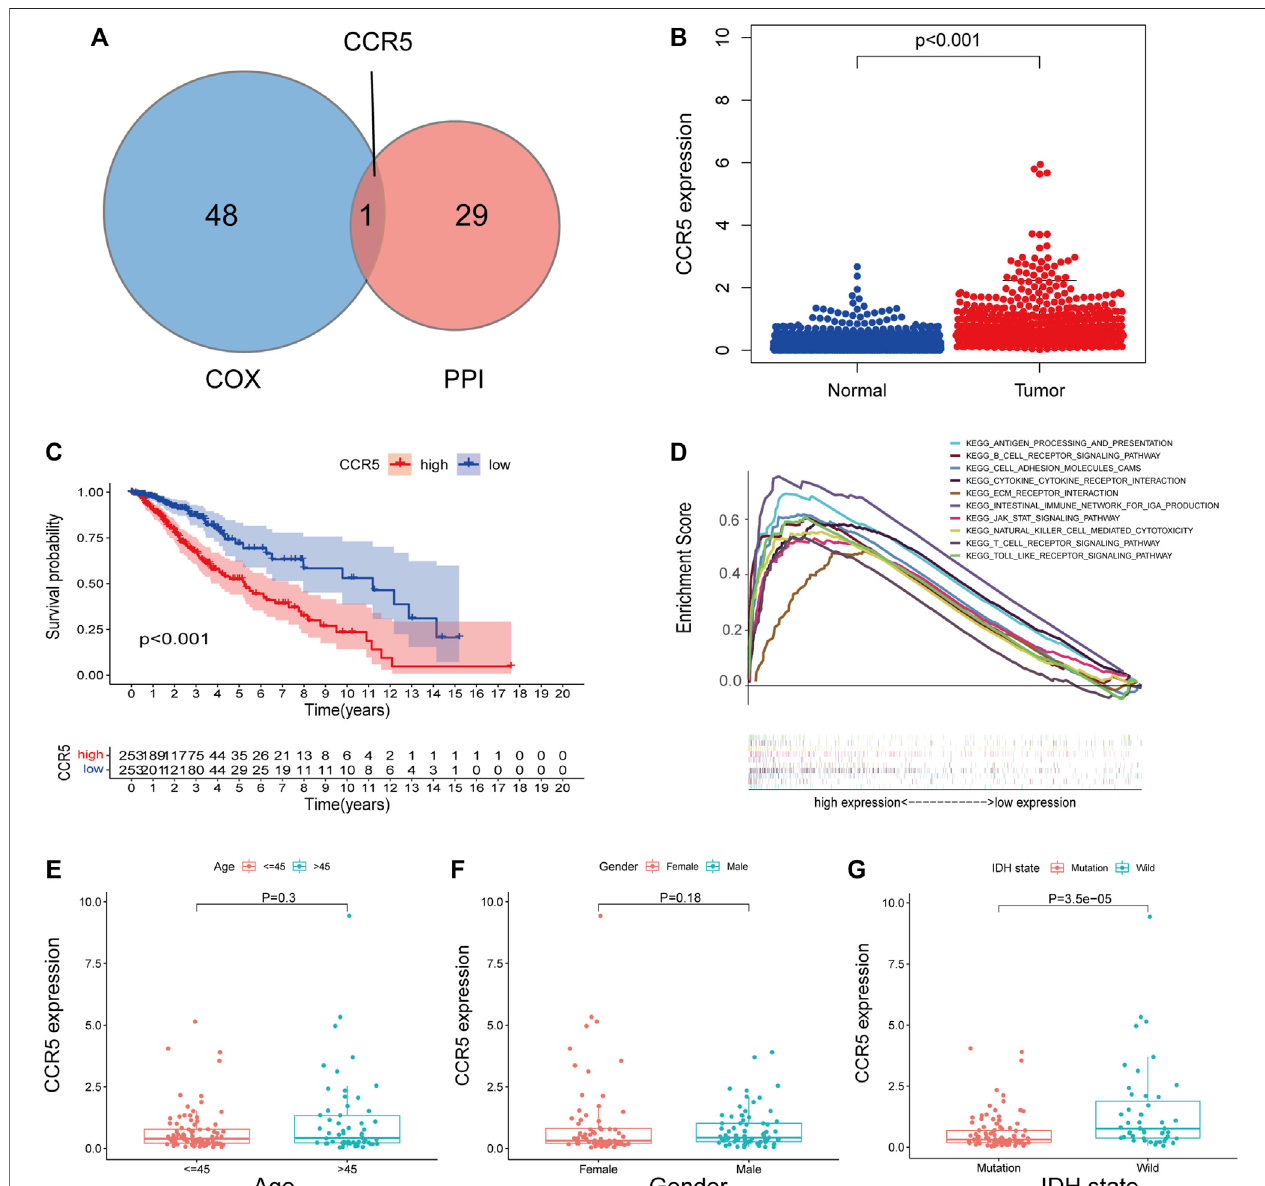
FIGURE6| Single-geneanalysisofCCR5inthetrainingsetbasedontheTCGAdatabase.TheVennplotshowedCCR5wasidenti fi edbasedontheintersectionof the 49 signi fi cant genes of Cox regression analyses and the 30 hub genes in the PPI network (A) . The expression of CCR5 in normal and tumor tissues of LGG (B) . The survival analysis of LGG patients with low and high CCR5 expression (C) .The GSEA analysis of CCR5 showed the top ten signaling pathways associated with the high expression of CCR5 (D) . The CCR5 expression was not associated with age and gender of patients (E,F) . The CCR5 protein expression was higher in LGG with IDH wildtype compared to IDH mutation (G)